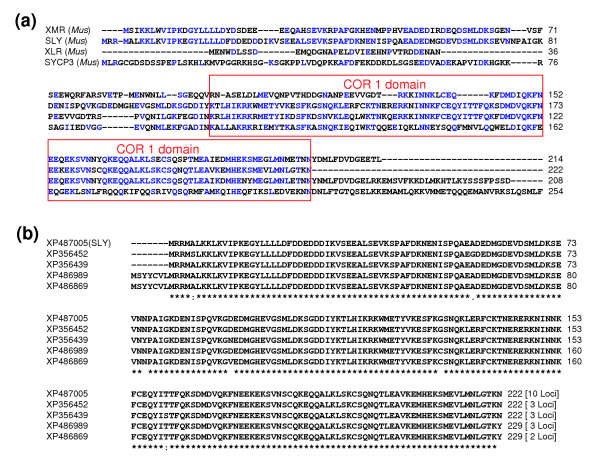
The protein encoding potential of Sly. (a) Sly encodes a putative protein with a COR1 region. This COR 1 region is shared with two closely related proteins, namely XMR and XLR, and with the less closely related synaptonemal complex protein SYCP3. (b) A comparison of the predicted protein sequence for SLY with the predicted proteins for other Sly related Y loci that are each represented by more than one copy (information collated from sequence information available in December 2004).